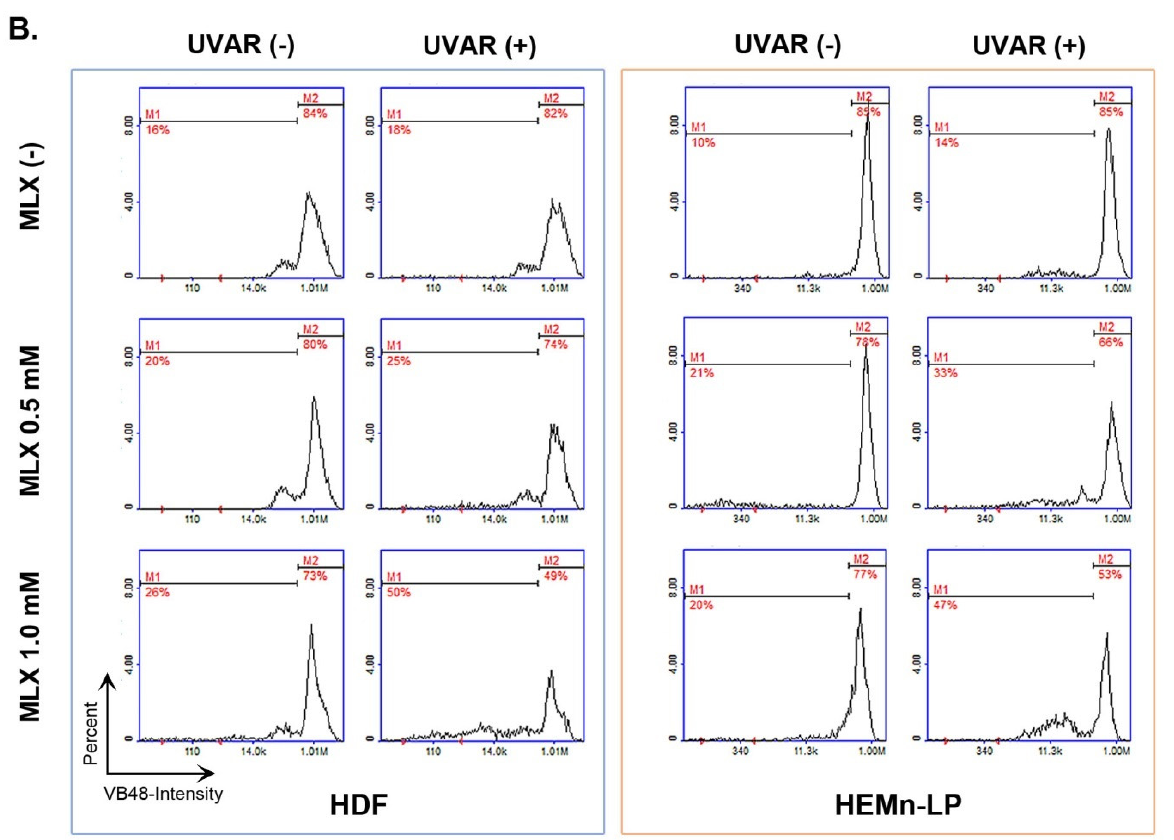
Figure 6. The evaluation of MLX and/or UVAR on the GSH level of fibroblasts and melanocytes. Obtained results are presented as a relative ratio of cells with low to cells with high GSH levels ( A ). The cells were pretreated with MLX at concentrations 0.5 mM and 1 mM, subsequently exposed to UVAR, and post-incubated in the medium for 24 h; ( B ) Representative histograms presenting the changes in the content of reduced thiols in cells treated with MLX and co-treated with MLX in concentrations of 0.5 mM and 1 mM and UVAR. ** p < 0.01 vs untreated cells (control), $$ p < 0.01 vs irradiated cells (not treated with meloxicam), ˆˆ p < 0.01 vs corresponding sample not treated with UVAR. 2.7. Redox Homeostasis of Human Normal Skin Cells Exposed to Meloxicam and UVA